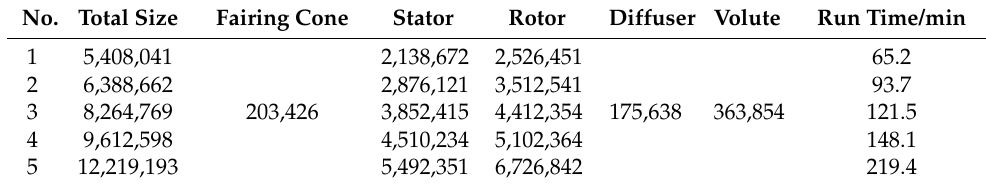
Table 3. Mesh sizes of the turbine components.